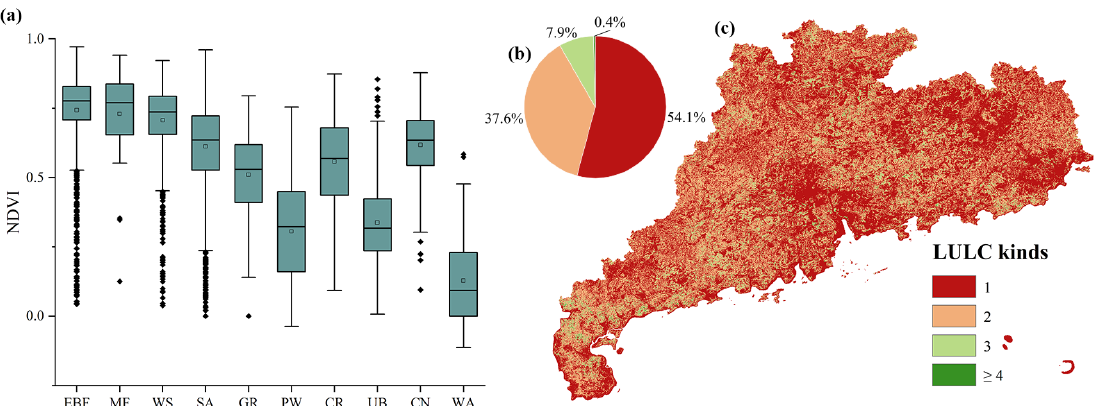
Figure 7. The NDVI of different LULC and the number of LULC types that have occurred in 20 years in southern China. ( a ) The NDVI boxplot of each LULC type in southern China. ( b ) The proportion of the number of pixels in different LULC types during the 20 years. ( c ) The number of different LULC types during the 20 years in each